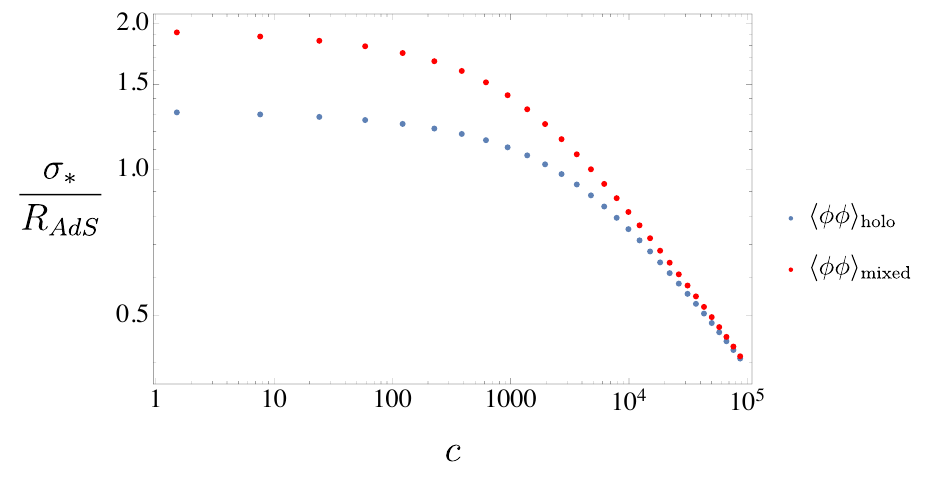
Figure 7 . This plot shows the same data as (cid:12)gure 5 for the radius of convergence (cid:27) c , except here we compare the radii of convergence of the holomorphic and the mixed contributions to the full correlator. Due to numerical limitations we only include the coe(cid:14)cients a n and b n up to n = 300, which means that these data are not as reliable as those of (cid:12)gure 5. Nevertheless, this plot provides clear evidence that the parametric scaling of (cid:27) holomorphic propagators when we restrict to the z -(cid:22) z